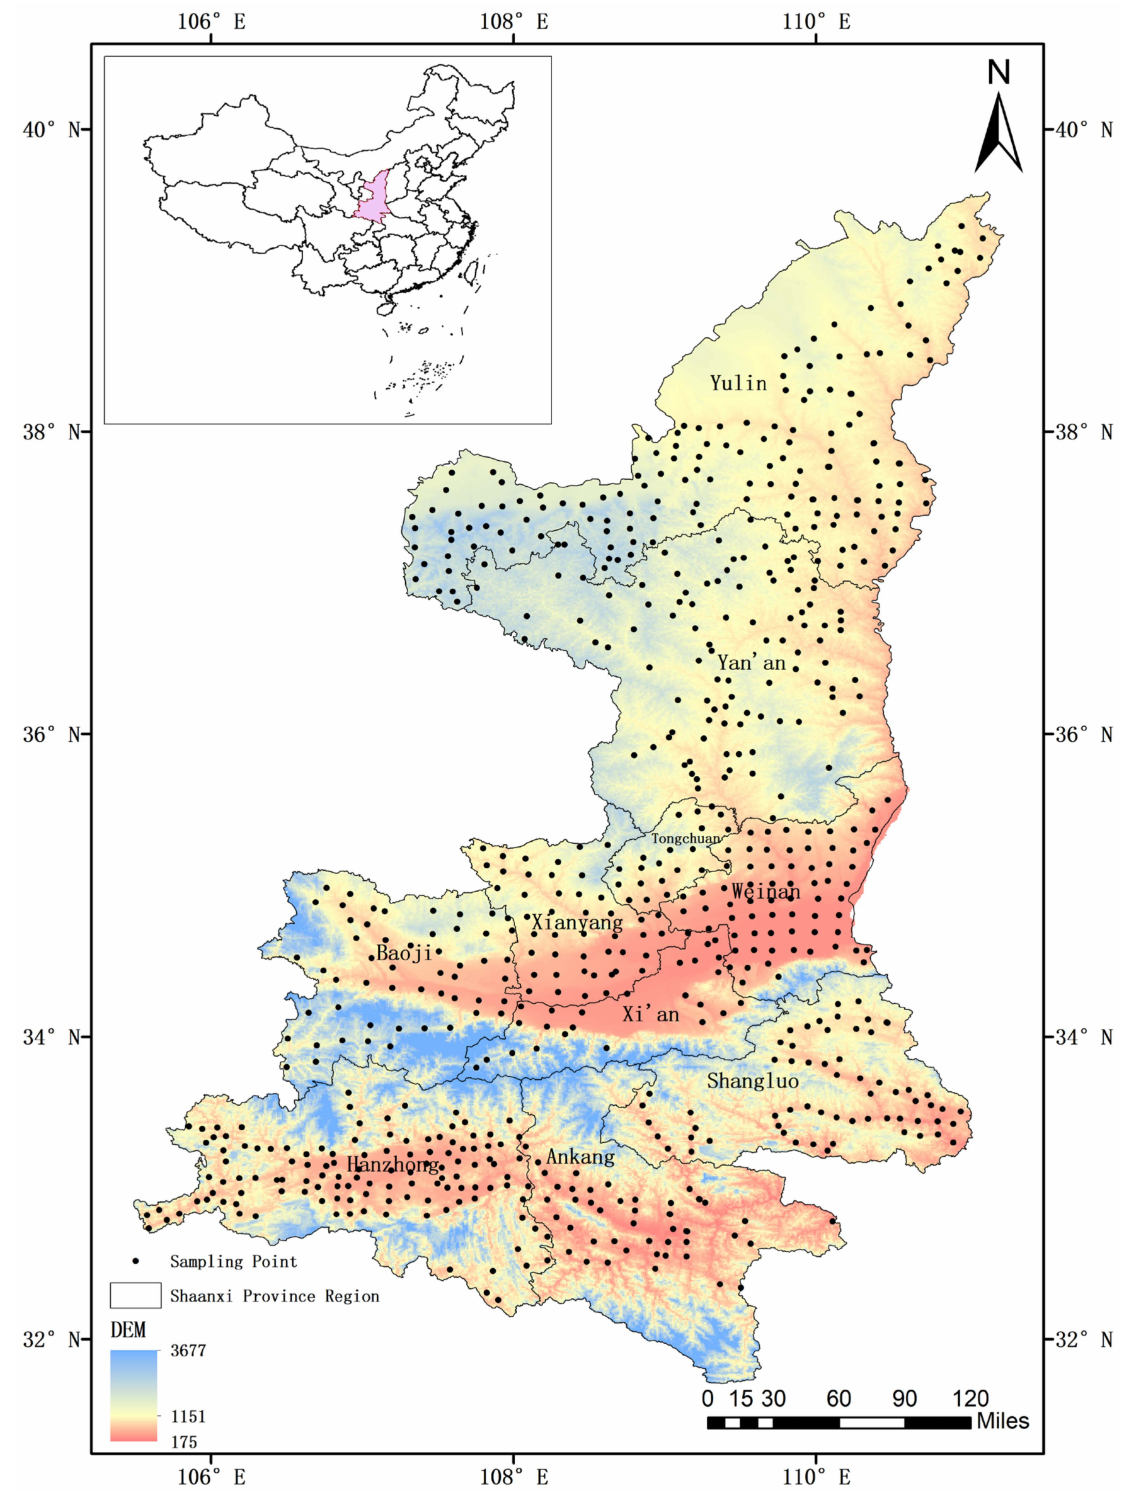
Figure 1. Distribution of soil sample collection points in Shaanxi